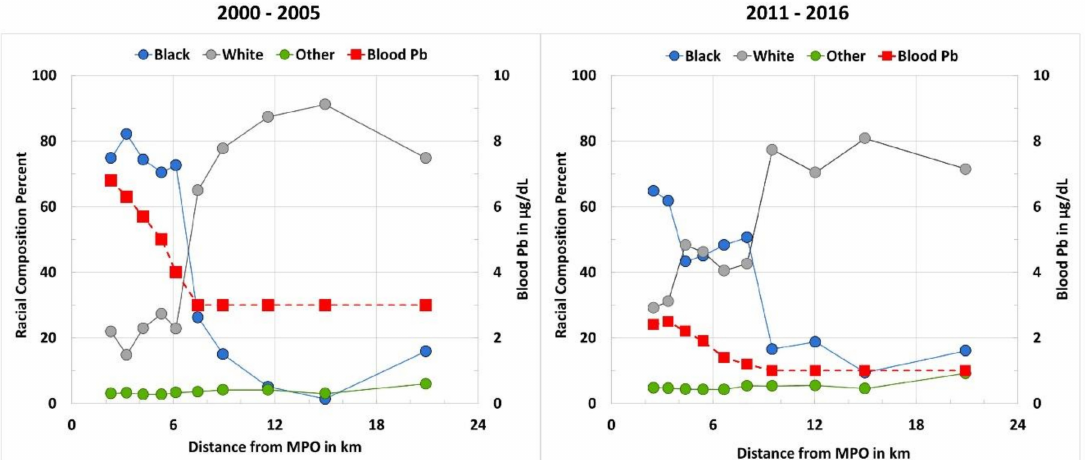
Figure 2. The relationship between racial composition and children’s median blood Pb as a function of distance sectors from the Main Post Office (MPO) to outlying communities. Children’s blood Pb (BPb) data (red squares with the scale on the right) are not disaggregated by race. The overall racial composition of the sampling areas are represented (blue, grey, and green circles with the scale on the